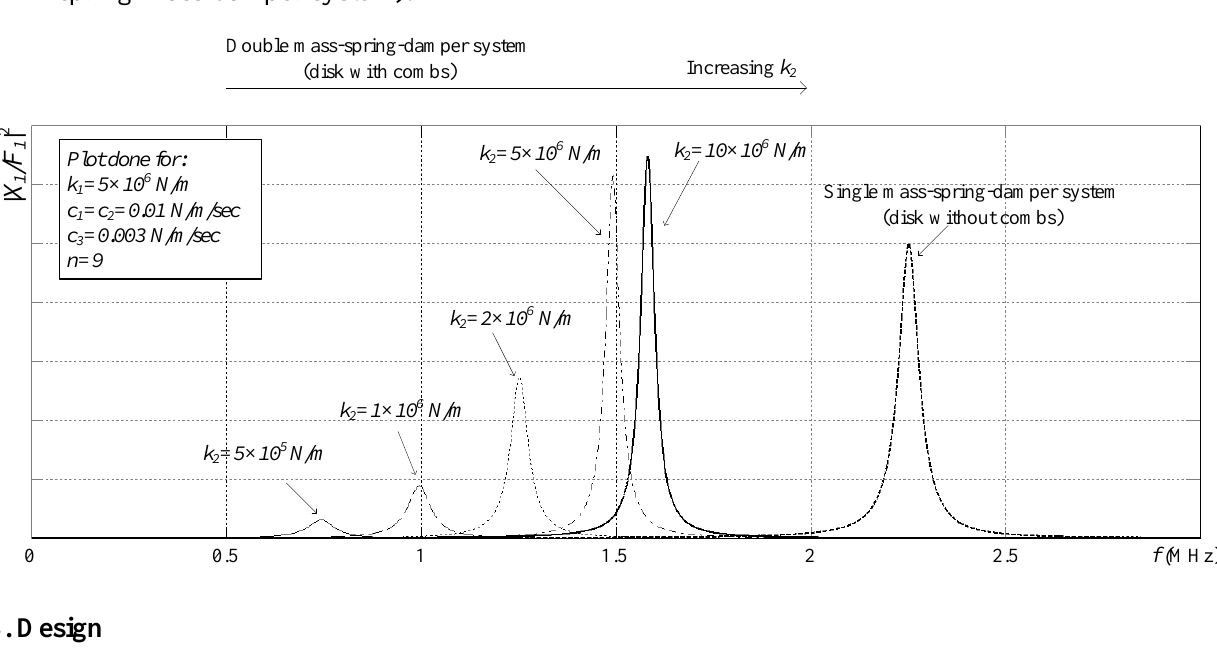
Figure 5. |X /F | 2 for the disk-comb combined structure (double spring-mass-damper 1 1 system for different secondary spring constants), and for the disk structure (single spring-mass-damper